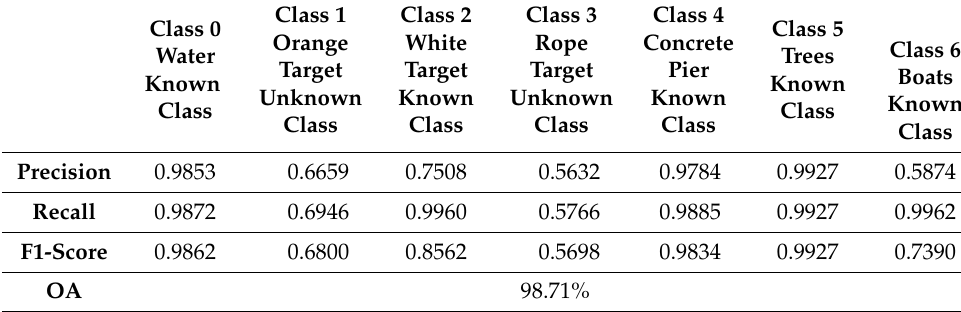
Table 2. Zero-Shot Learning